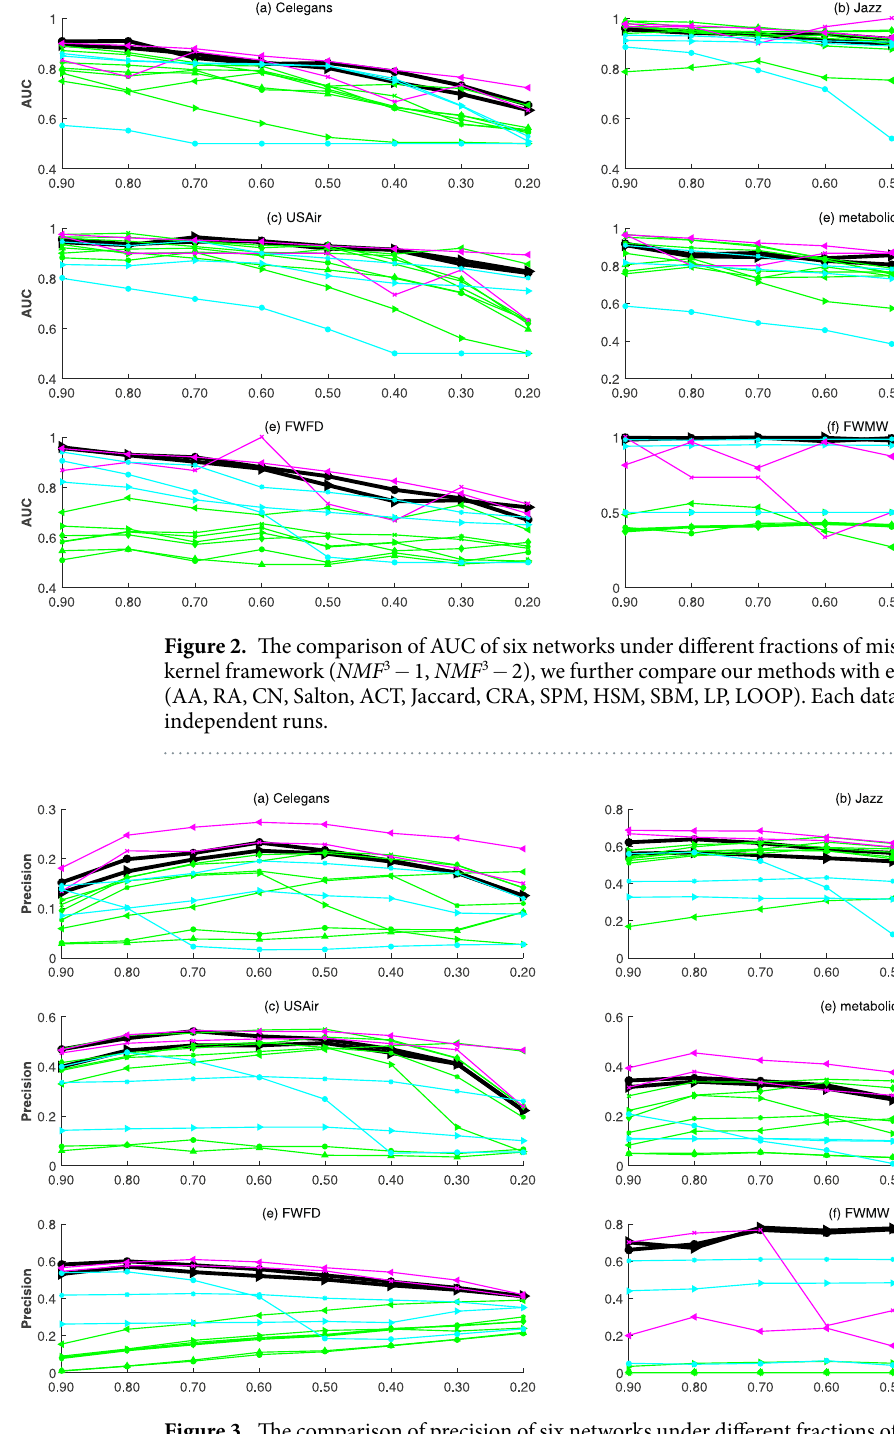
larger networks, especially for the SPM and LOOP). The black lines represent the performance of the proposed NMF 3 − 1 and NMF 3 − 2 methods, the purple lines correspond to the SPM and LOOP methods, the rest lines are the other global methods (HSM, SBM, and LR) and similarity-based methods. From the results, it is obvious that SPM, LOOP and our methods have better and competitive performance that others. There are two different